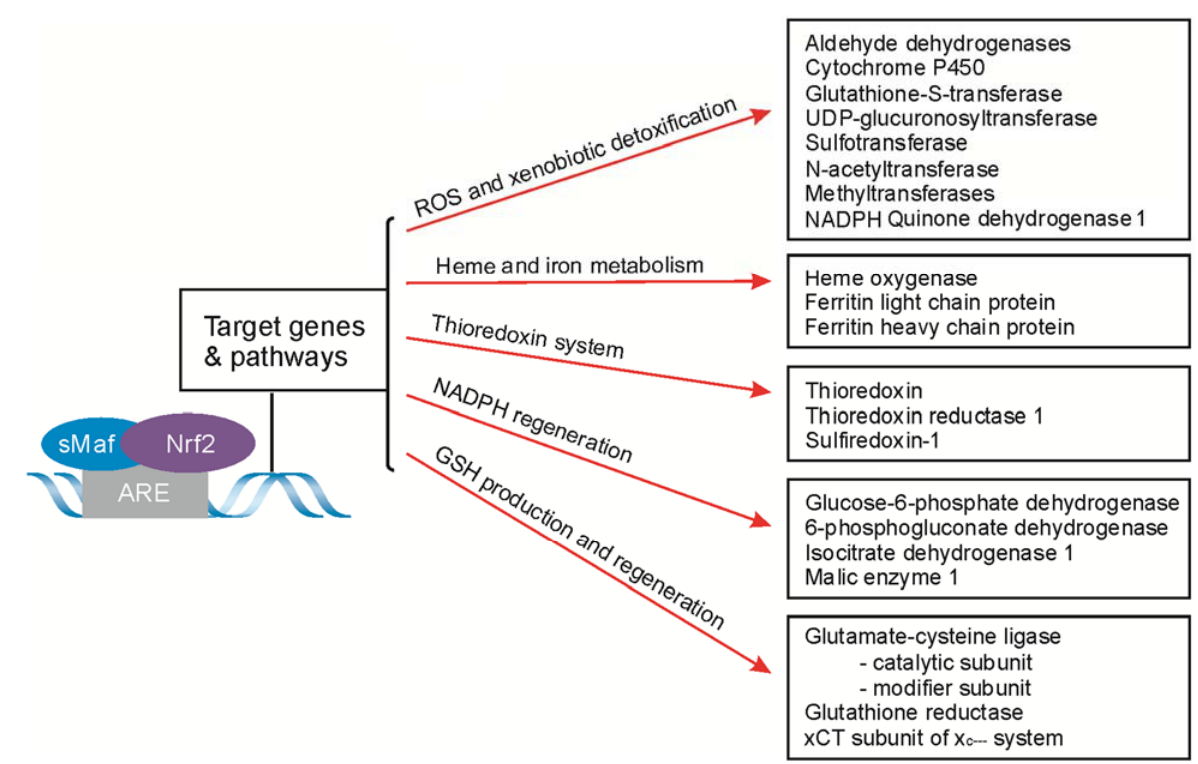
Figure 3. The principal cytoprotective enzymes encoded by the ARE-driven genes. GSH, glutathione; NADPH, reduced nicotinamide adenine dinucleotide phosphate; UDP, uridine diphosphate; xCT, cystine/glutamate transporter.